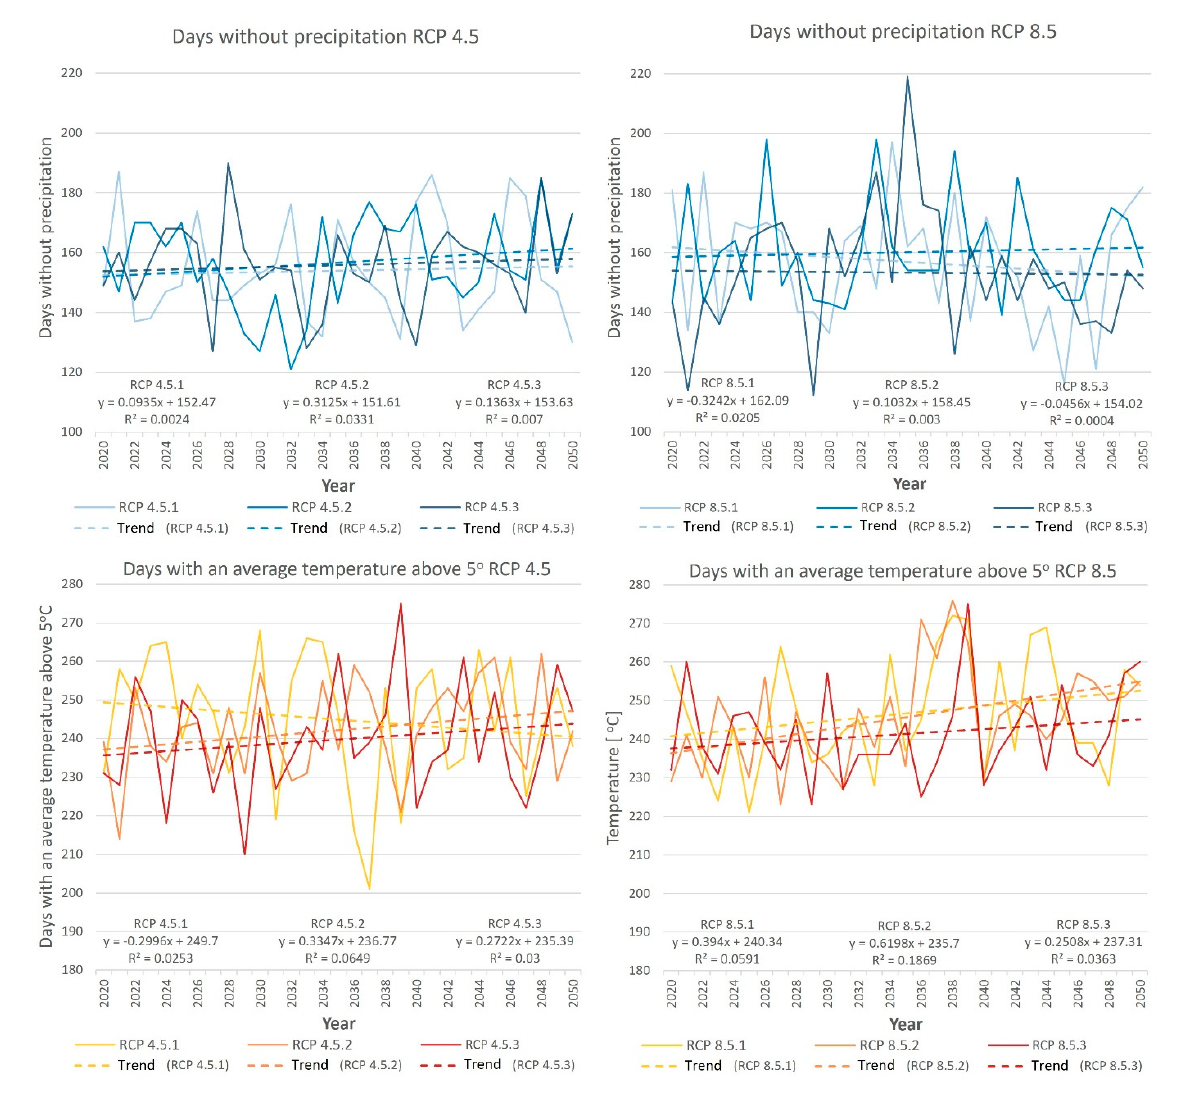
Figure 9. The average annual sum of days without precipitation and the average annual sum of days with temperatures above 5 °C in the Bystra River basin in the years 2020–2050 for individual climate projections in the RCP 4.5 and RCP 8.5 scenarios together (own study).